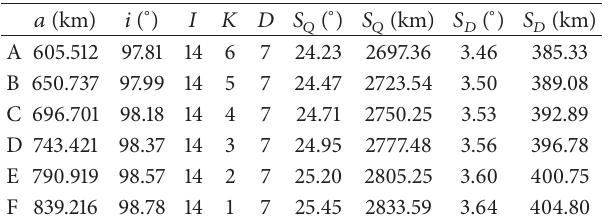
Table 1: Parameters of some repeating sun-synchronous orbits. 𝑎